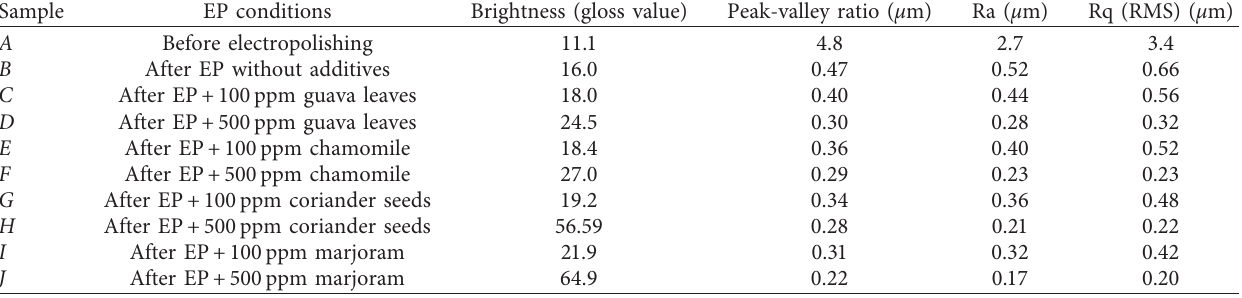
Table 4: Measured roughness (Ra), Rq (RMS), Peak-valley ratio, and brightness of C-steel samples. Sample